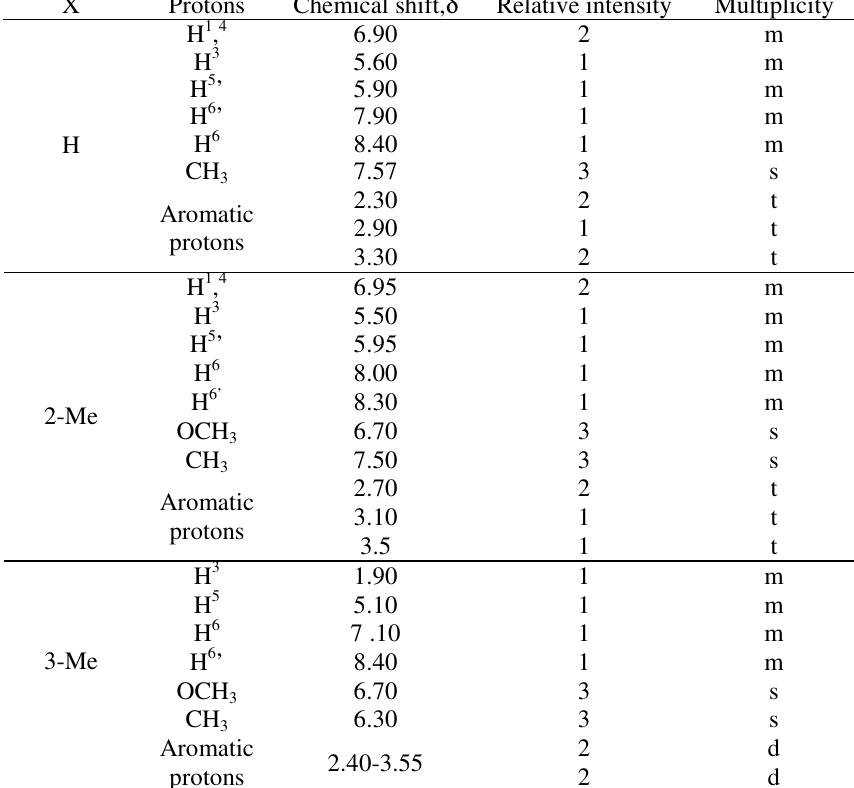
Table 3. 1 H.NMR spectra data for the tricarbonyl 1,4- η -5-exo-( N -pyridino derivatives) 2- methoxycyclohexa-1,3-diene iron